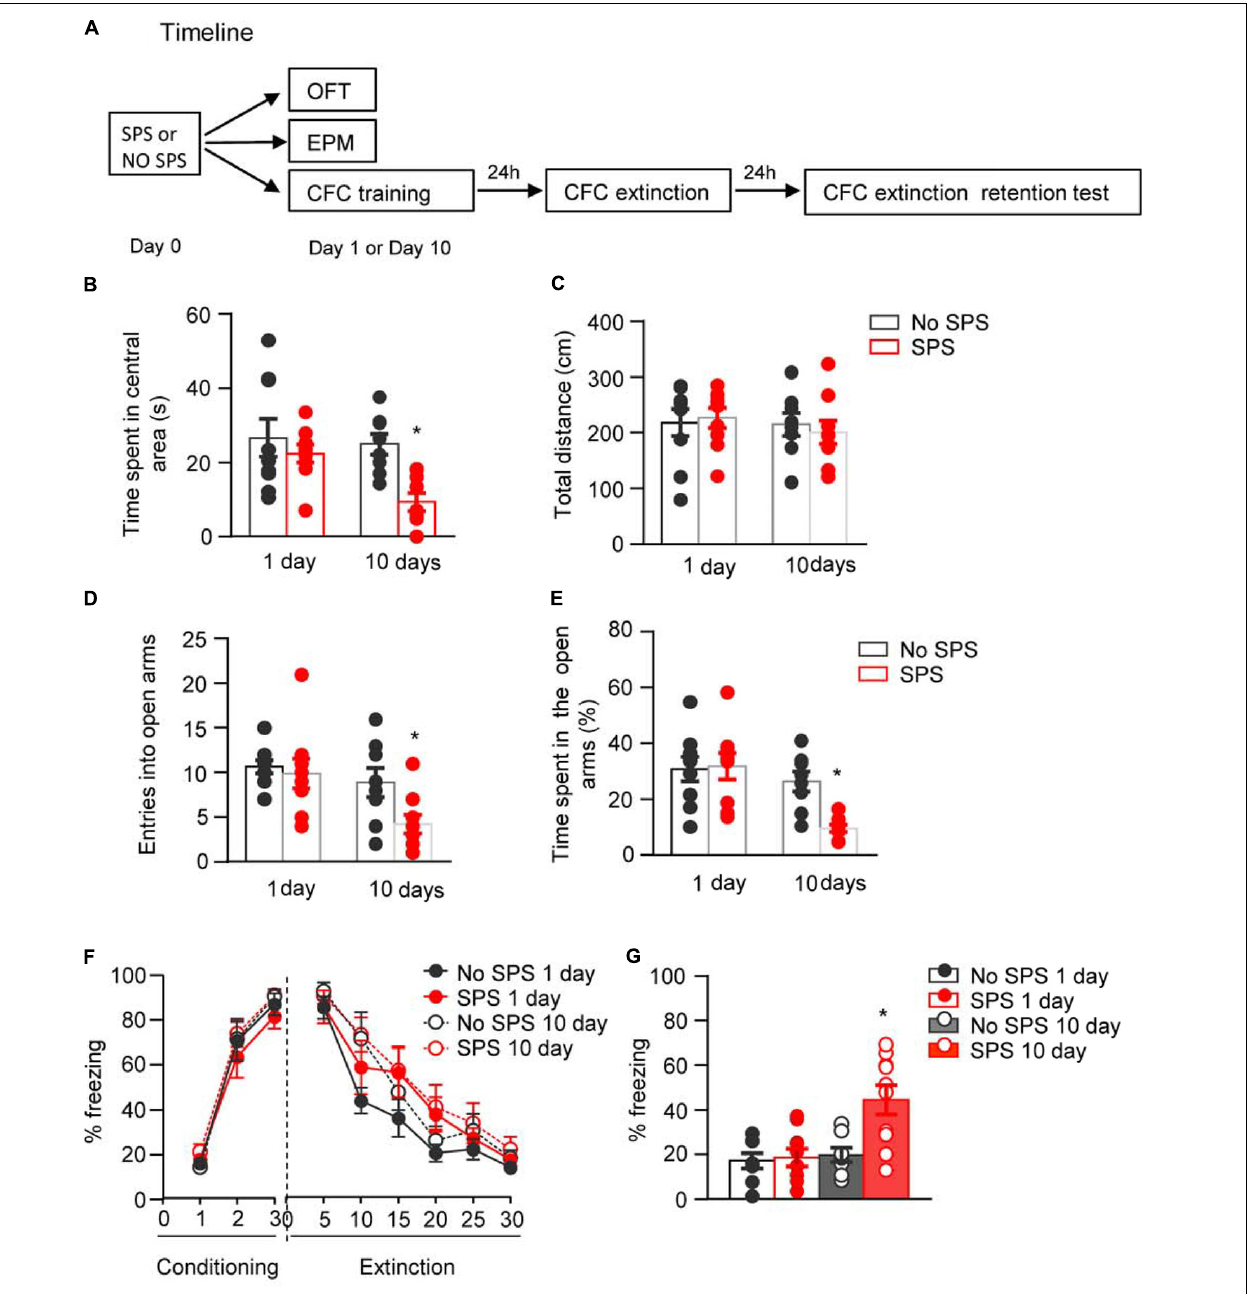
FIGURE 1 | Effect of single prolonged stress (SPS) on anxiety-like behaviors and fear extinction on day 1 or day 10 after stress. (A) Experimental procedures. We treated rats with SPS procedure. About 1 day or 10 days later, we examined the anxiety-like behaviors with open field and elevated plus maze, and examined fear extinction with contextual fear conditioning. (B,C) Time spent in the central area (B) and the total locomotor distance (C) in different experimental conditions in open field test. (D,E) The entries into open arms (D) and time spent in open arms (E) in different experimental conditions in elevated plus maze test. (F,G) Formation and extinction of fear conditioning (F) and memory retention of fear extinction (G) in different experimental conditions. n = 8–10 per experimental condition. Data are mean ± SEM 2 . ∗ Different from all other groups, one-way ANOVA, p < 0.05.